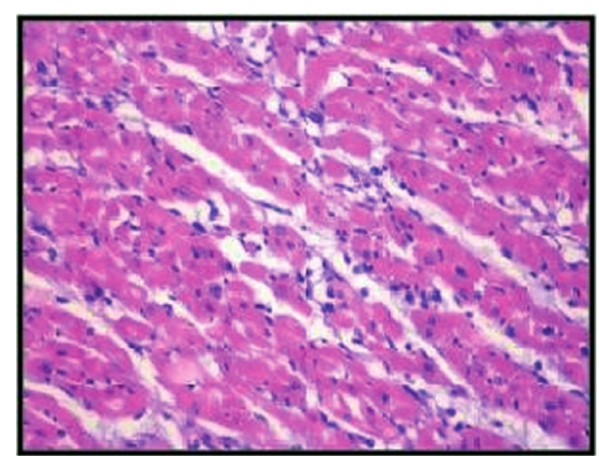
Fig. 1 - Estudo histopatológico demonstrando tecido miocárdico com ausência de alterações histológicas (Grau 0)